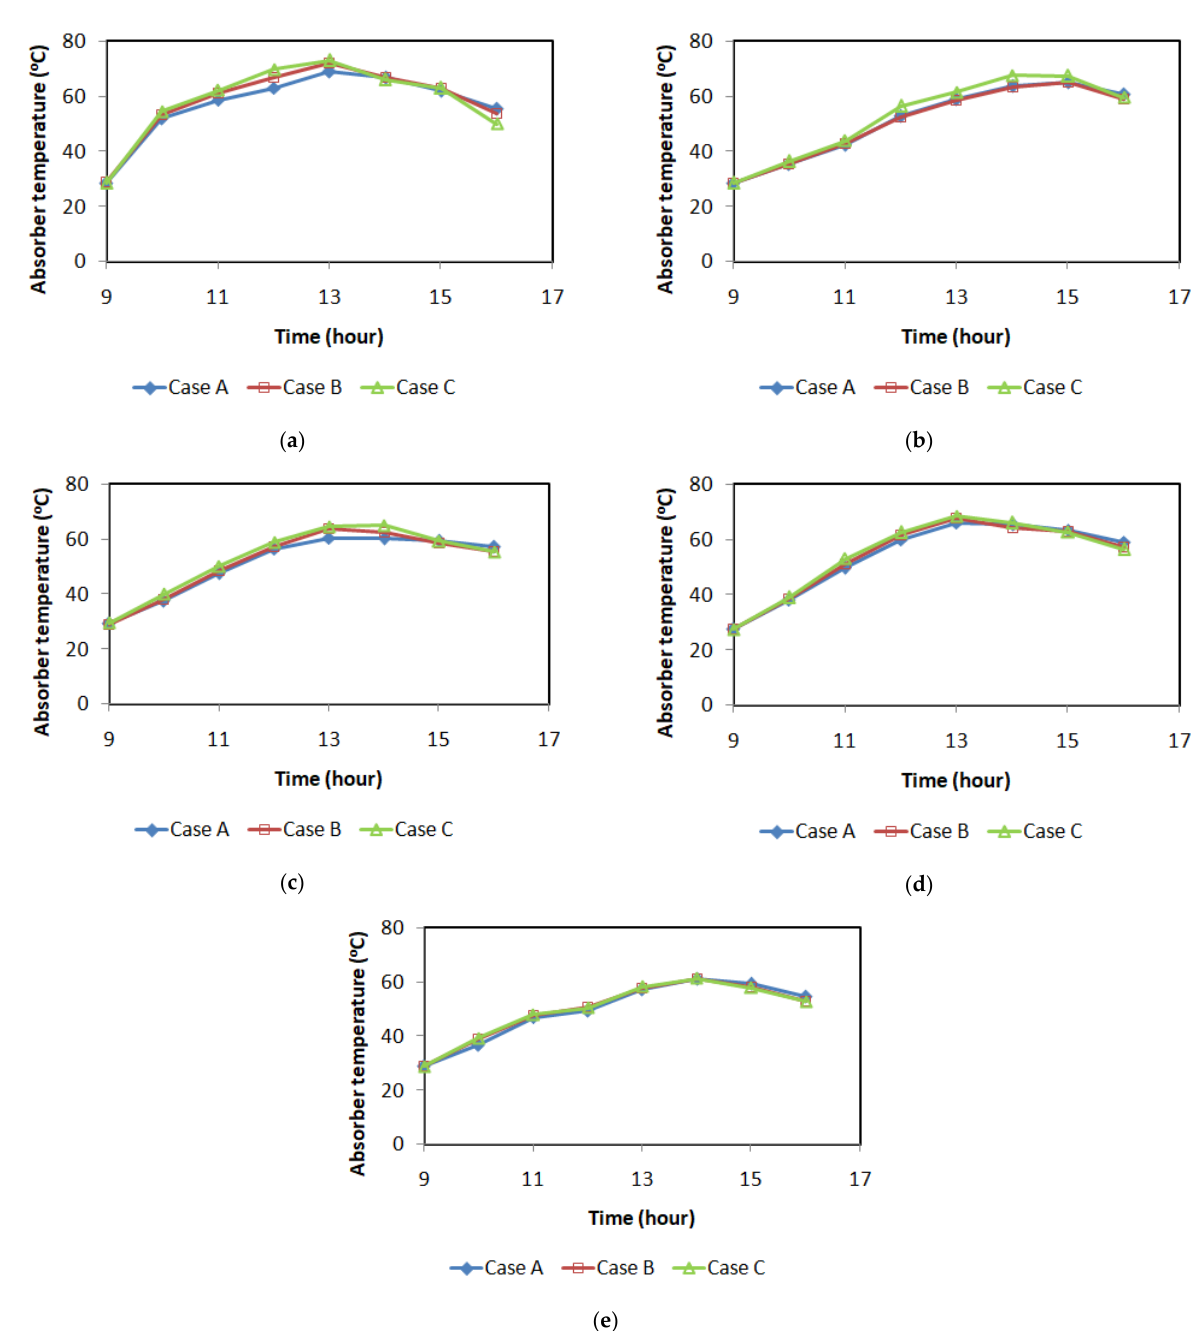
Figure 4. Relationship of absorber temperatures and observation time for five days: ( a ) Day 1, ( b ) Day 2, ( c ) Day 3, ( d ) Day 4, and ( e ) Day 5.